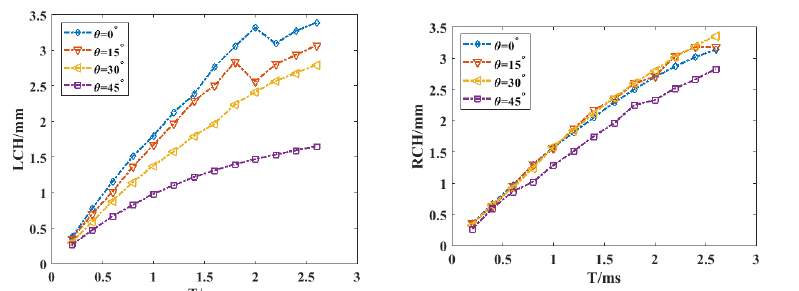
Figure 7. Crown height of a drop impingement onto a dynamic film at different impact angles.